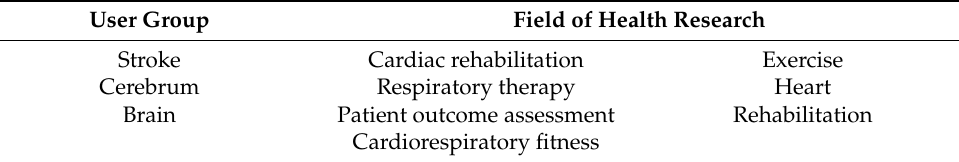
Table 1. MeSH search terms.